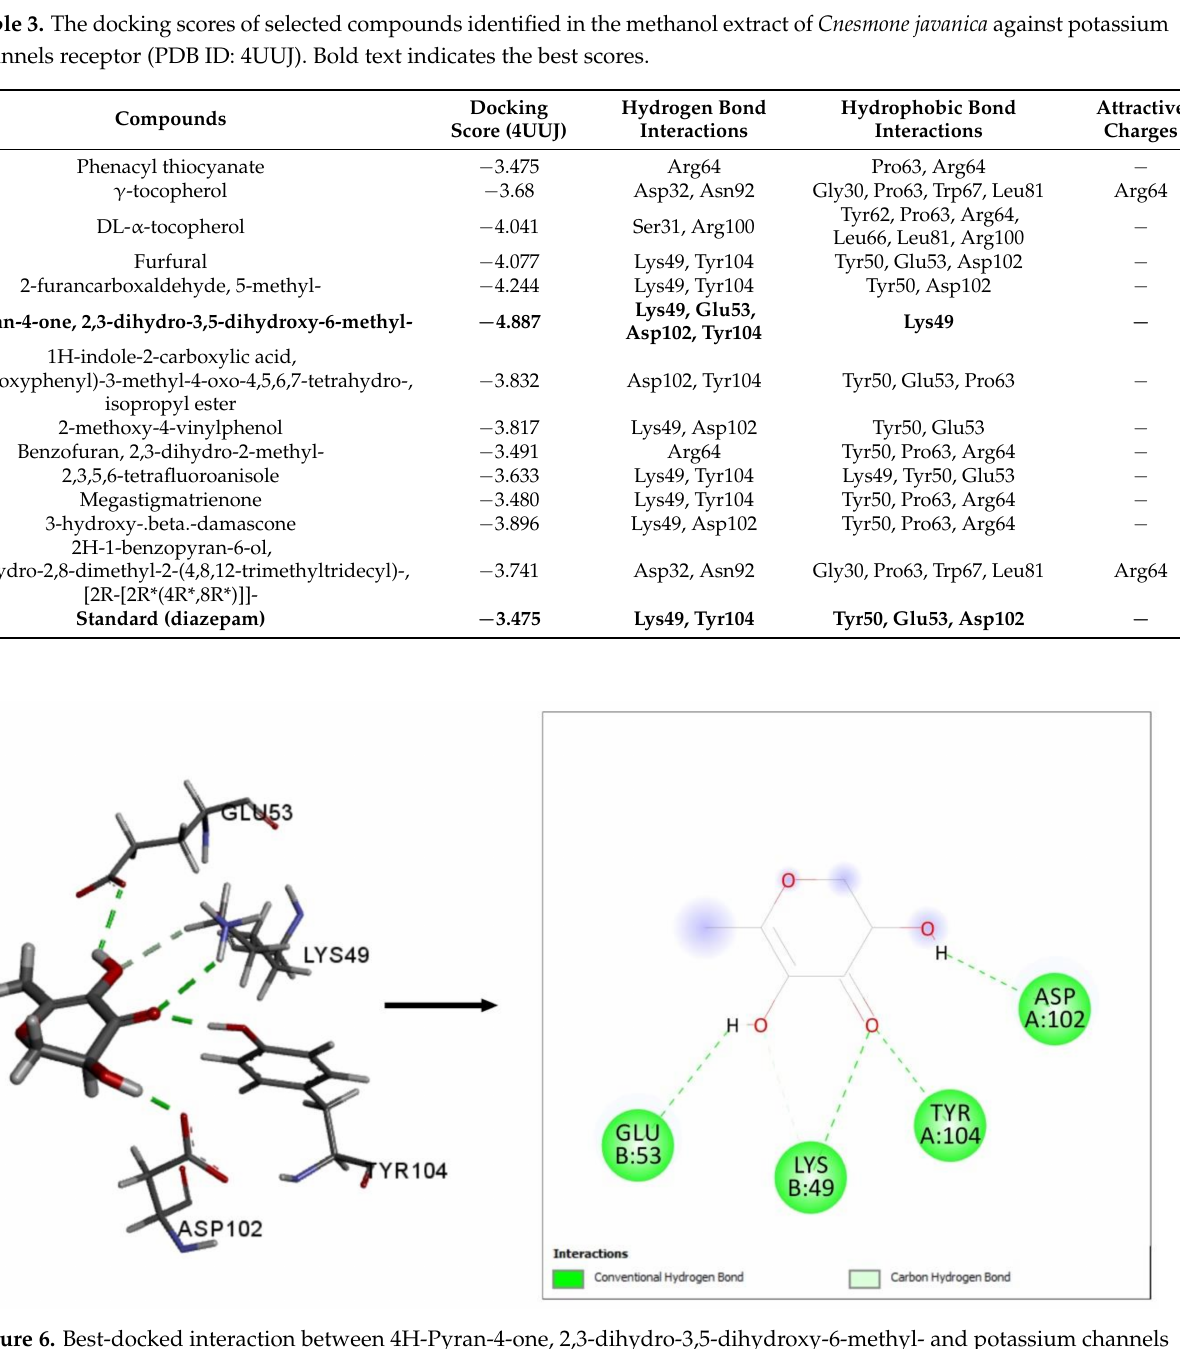
Figure 6. Best-docked interaction between 4H-Pyran-4-one, 2,3-dihydro-3,5-dihydroxy-6-methyl- and potassium channels receptor (PDB ID: